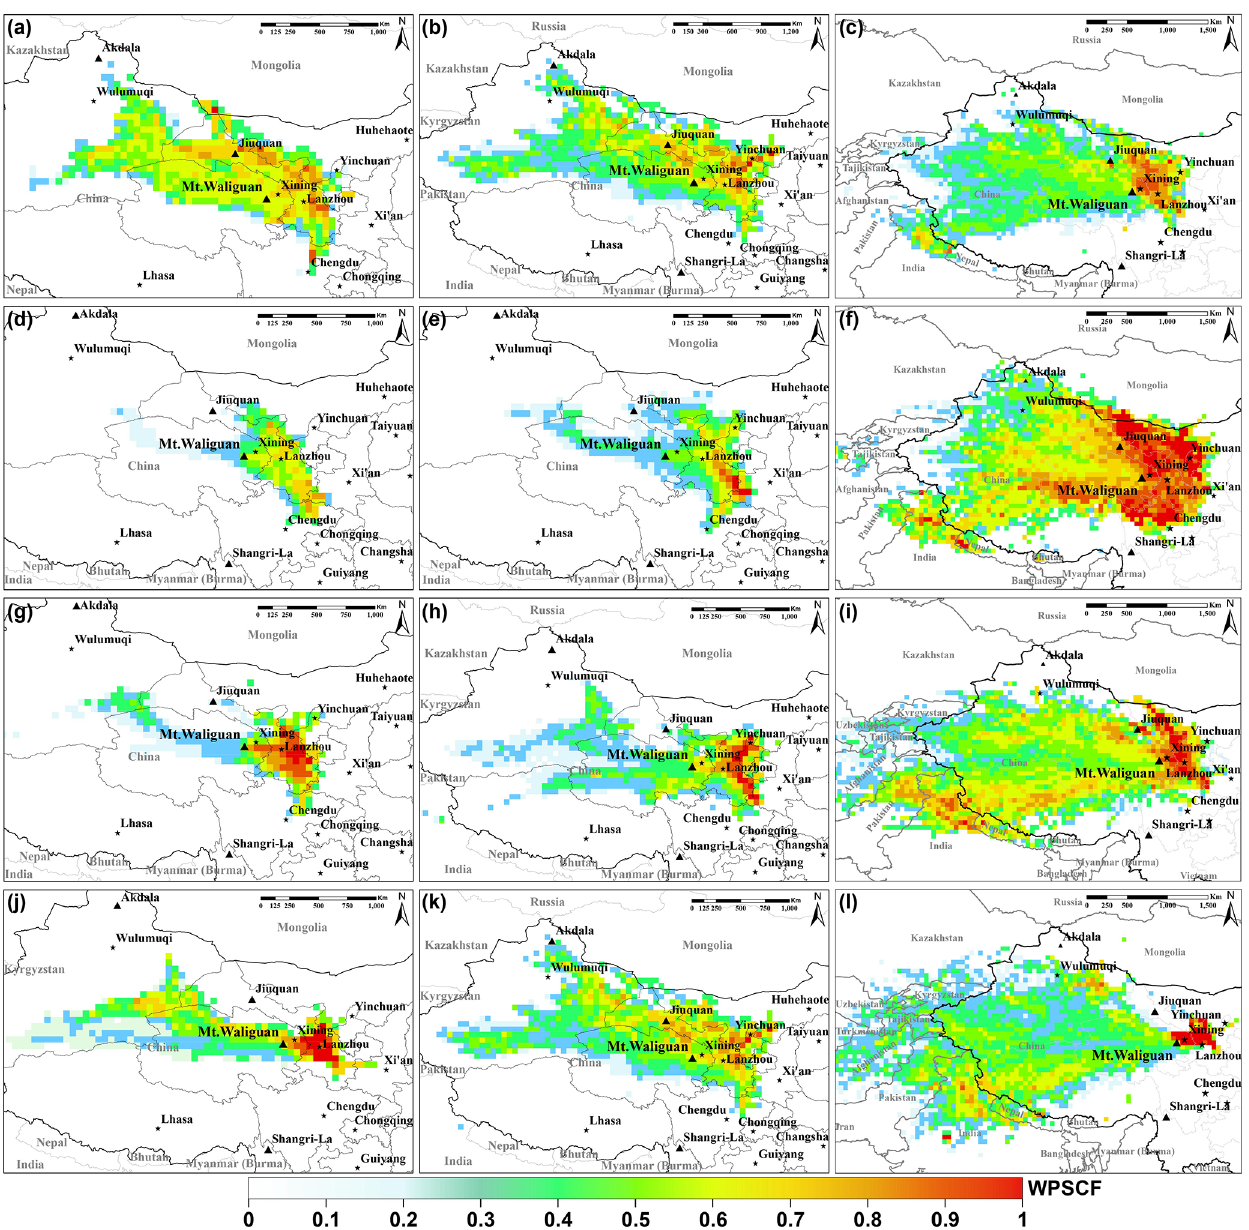
Figure 7. The geographical distribution of the weighted potential sources of CH 4 in different periods over 2004–2019 at the WLG station. The gradient color shows the strong levels of potential source regions in different seasons, i.e., spring (a, b, c) , summer (d, e, f) , autumn (g, h, i) , and winter (j, k, l) and different periods, i.e., 2004–2007 (a, d, g, j) , 2008–2012 (b, e, h, k) , and 2013–2019 (c, f, i, l)